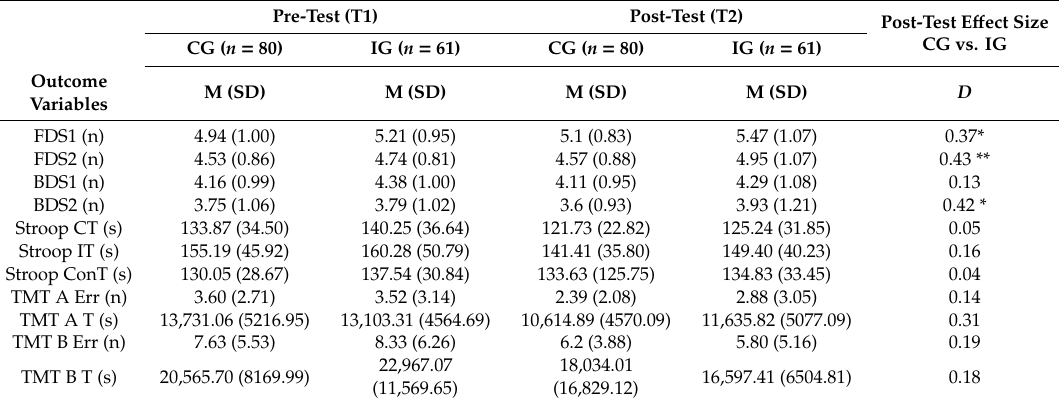
Table 3. Means, standard deviations, and e ff ect size for digit span test, Stroop, and trail making test (TMT) scores before and after ESA-Program intervention for CG and